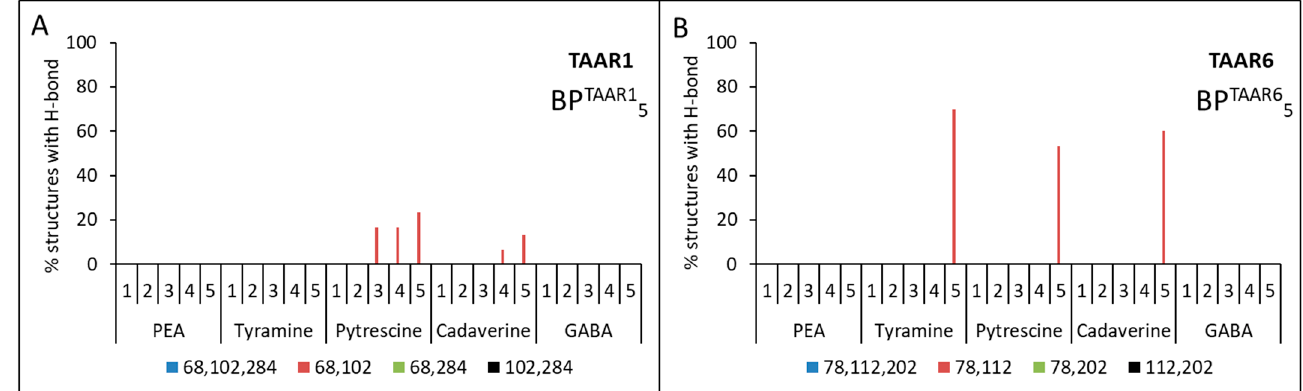
Figure 6. Percentage of structures in which the formation of two hydrogen bonds is observed sim- ultaneously between ligands and the corresponding Asp residues of the receptors in a series of com- putational experiments when no binding pocket BP TAAR15 ( A ) and BP TAAR65 ( B ) is specified. computational experiments when no binding pocket BP TAAR1 5 ( A ) and BP TAAR6 5 ( B ) is specified.